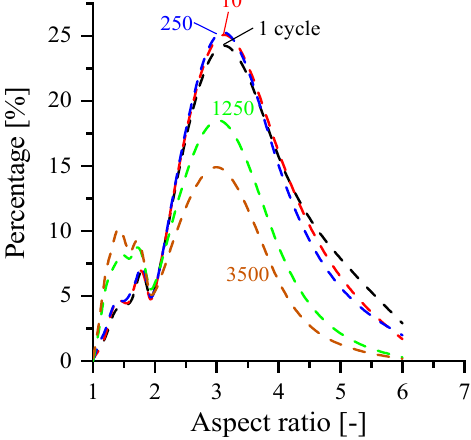
Figure 5. Evolution of martensite lath aspect ratio in P91 with an increasing number of TMF cycles.